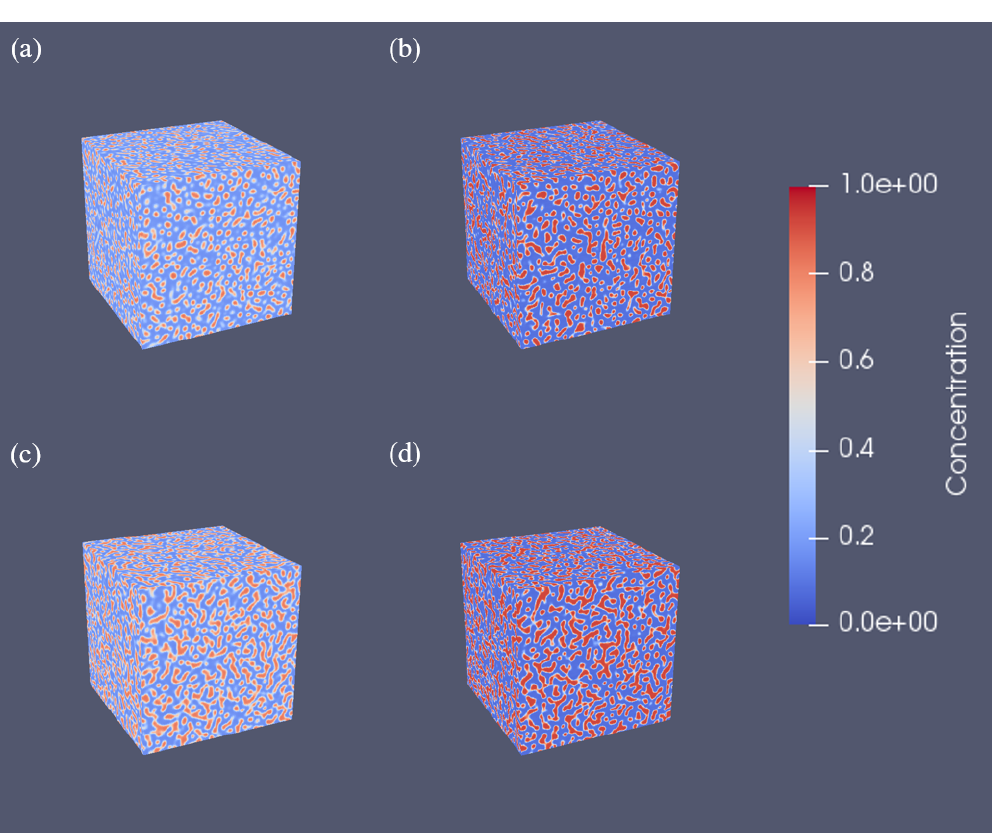
Figure 17. Cr concentrations at t ∗ = 2.5 × 10 6 . The system size is 256 ∆ x × 256 ∆ y × 256 ∆ z: ( a ) 35Cr-1Al, ( b ) 35Cr-10Al, ( c ) 40Cr-1Al, and ( d )